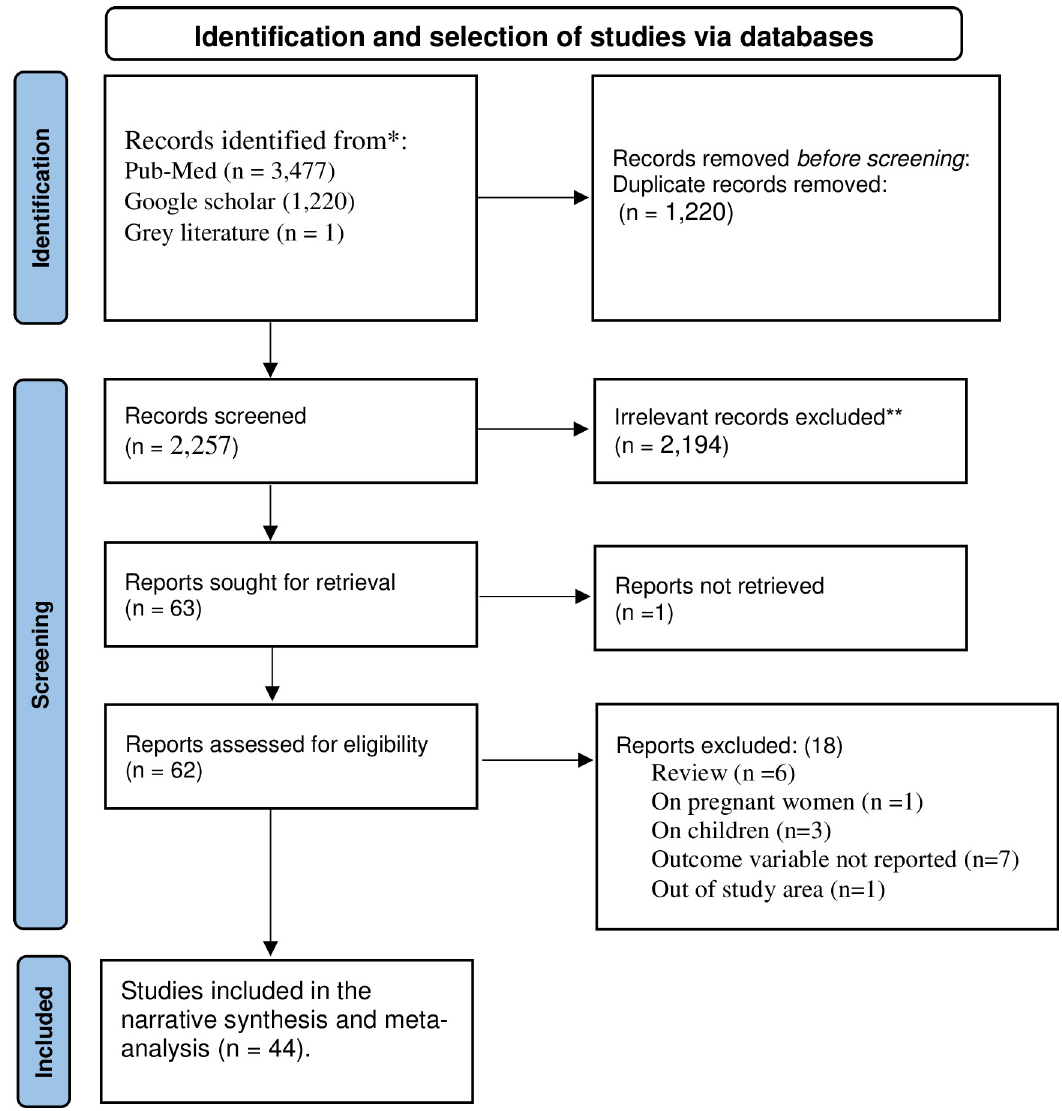
Fig 1. Flow chart showing the sequence of study selection on undernutrition among adult PLWHIV in sub-Saharan Africa, 2009–2021.